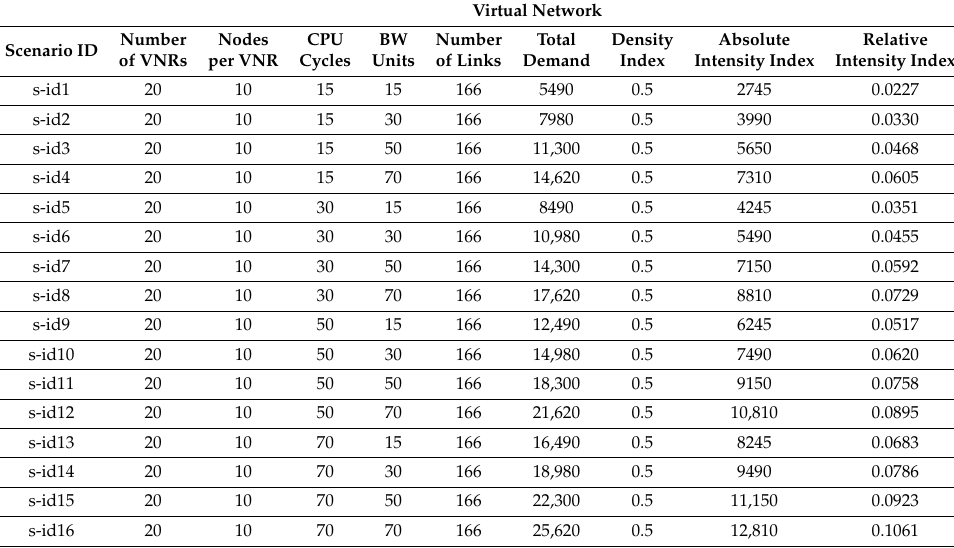
Table 7. RII of R-ViNE-PS in the few–large parameter